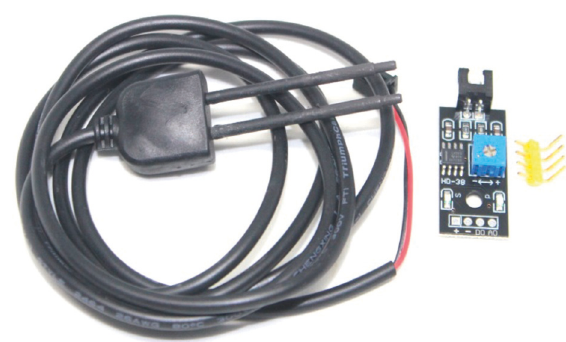
Figure 4: Corrosion-resistant soil moisture sensor (as adopted from https://www.google.com/search?q � Corrosion+resistant+soil